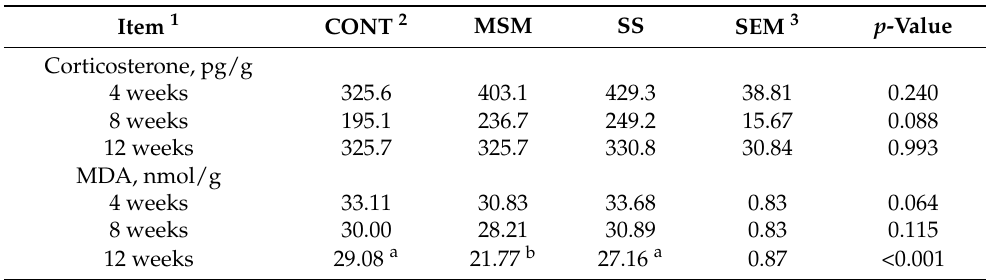
Table 5. Effects of dietary sulfur on corticosterone and malondialdehyde contents of egg yolks in laying hens ( n = 8).